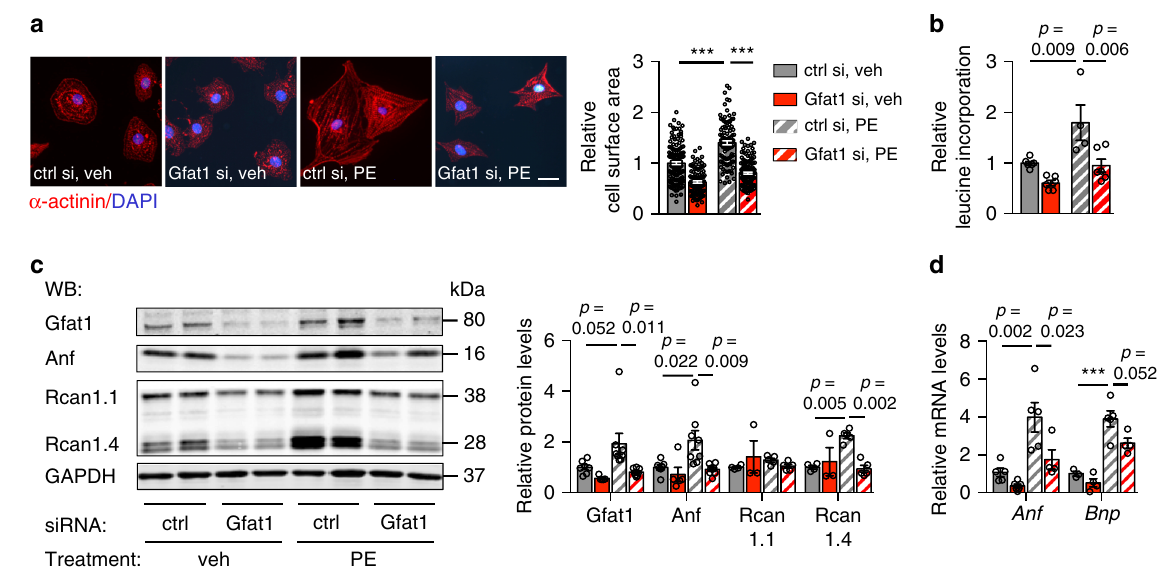
Fig. 3 Gfat1 is required for hypertrophic growth in cardiomyocytes. a NRVMs were fi rst transfected with either control (ctrl si) or Gfat1 (Gfat1 si) siRNA. PE was then used to trigger cardiomyocyte hypertrophic growth. The cells were harvested for immuno fl uorescence staining with α -actinin antibody (red) and DAPI (blue). Scale: 20 μ m. Quanti fi cation showed a signi fi cant decrease of cardiomyocyte surface area by Gfat1 silencing. N = 160 cells for ctrl si/veh; n = 102 cells for ctrl si/PE; n = 108 cells for Gfat1 si/veh; n = 140 cells for Gfat1 si/PE. At least three independent experiments were conducted with two to three samples/group/experiment. b Leucine incorporation assay showed Gfat1 knockdown led to strong suppression of cell growth compared with control siRNA. N = 4 for ctrl si/PE group; n = 6 for all other groups. c Representative immunoblots of Gfat1, Rcan1.1, Rcan1.4, and Anf after PE treatment are shown. Quanti fi cation is at the right. N = 3 – 8. d Gfat1 silencing in NRVMs inhibited hypertrophic marker expression at the mRNA levels, as examined by real-time PCR analysis. N = 3 – 6. Data are shown as mean ± SEM. Signi fi cance was calculated by two-way ANOVA, followed by Tukey ’ s test. *** p < 0.001. Source data are provided as a Source Data fi